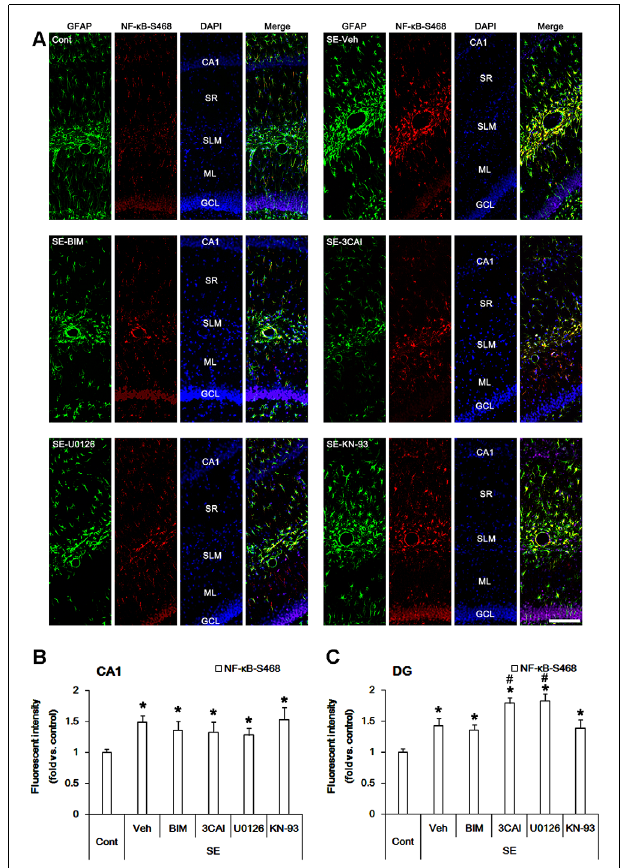
FIGURE 5 | Effect of SE on NF- κ B-S468 phosphorylation in the hippocampus. SE increases NF- κ B-S468 phosphorylation in CA1 astrocytes, which is unaffected by BIM, 3CAI, U0126 and KN-93. SE also elevates NF- κ B-S468 phosphorylation in dentate astrocytes, which is enhanced by 3CAI and U0126. (A) Representative immunofluorescent images for GFAP and NF- κ B-S468 phosphorylation following SE. Bar = 100 µ m. Abbreviations: CA1, CA1 pyramidal cell layer; SR, stratum radiatum; SLM, stratum lacunosum-moleculare; ML, molecular layer; GCL, dentate granule cell layer. (B,C) Quantification of the fluorescent intensities of NF- κ B-S468 phosphorylation in CA1 astrocytes (B) and dentate astrocytes (C) . Error bars indicate SEM ( ∗ , # p < 0.05 vs. control- and vehicle-treated animals, respectively; n = 7, respectively).